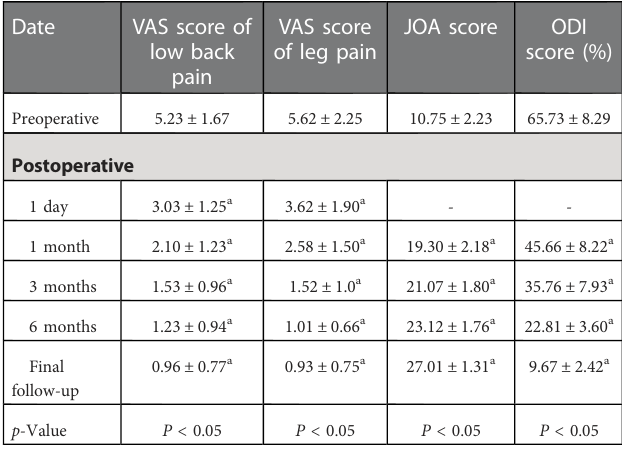
TABLE 3 Clinical outcomes (VAS, JOA, and ODI) pre- and post-surgery.